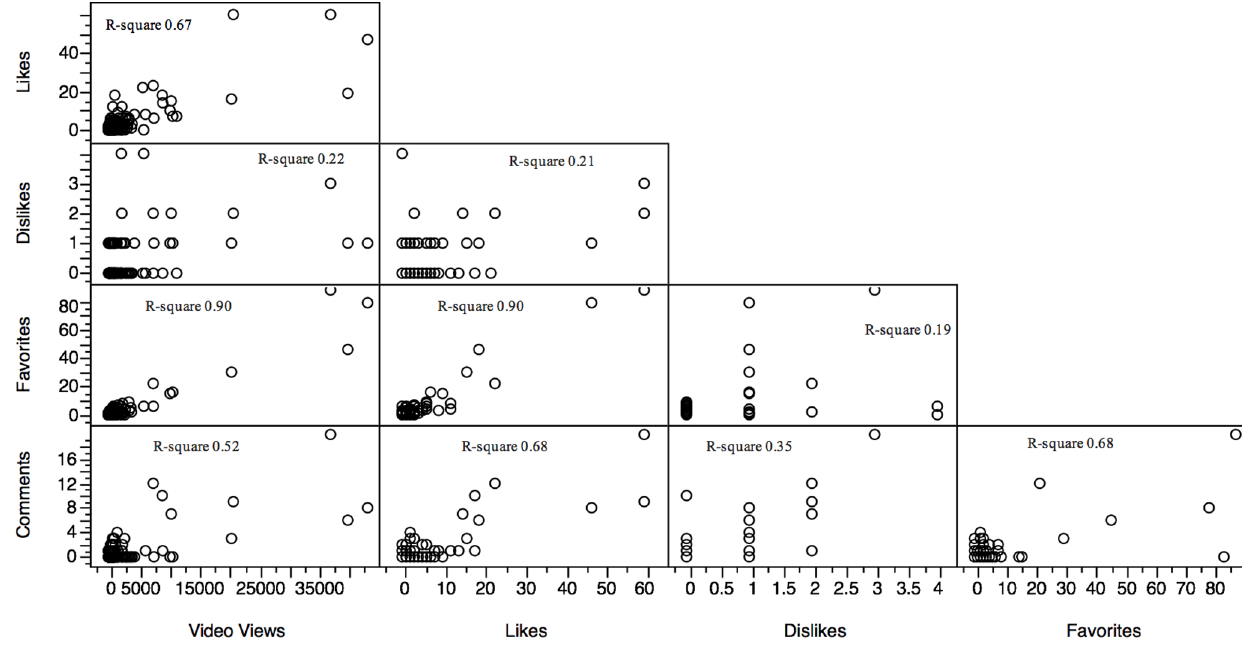
Figure 1. Scatterplot showing correlations between five user engagement measurements. doi:10.1371/journal.pone.0082469.g001 PLOS ONE |